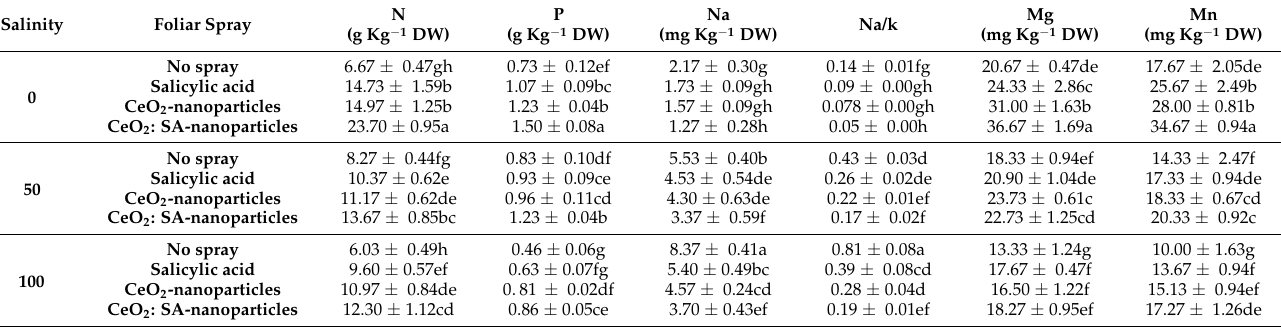
Table 11. Comparison of means for the effects of salinity (0–50 and 100 mM NaCl) and foliar applications (no spray, salicylic acid, CeO 2 -nanoparticles, and CeO 2 : SA-nanoparticles) on the content of some nutrients in Portulaca oleracea